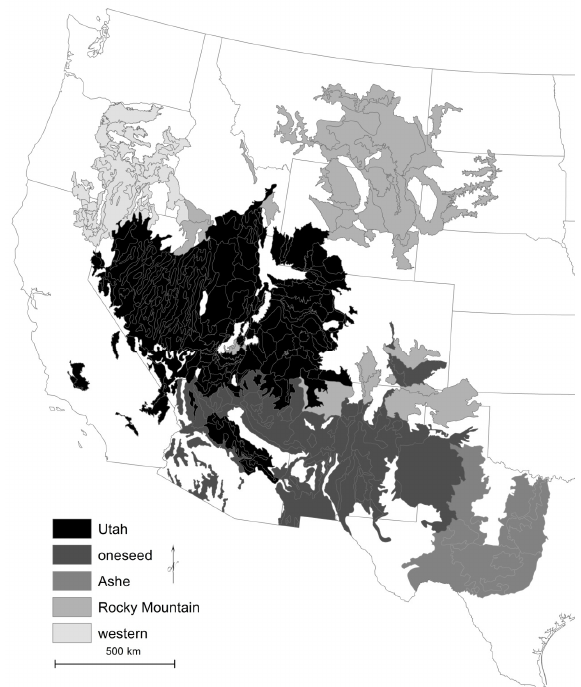
Figure 1. Range of most abundant western Juniperus species where recent composition was ≥ 10% in ecological sections (outlined and shaded). There was little overlap among species ranges at ≥ 10% composition, although less common Pinchot juniper and redberry juniper (not shown) overlapped Ashe juniper and alligator juniper (not shown) overlapped oneseed juniper.